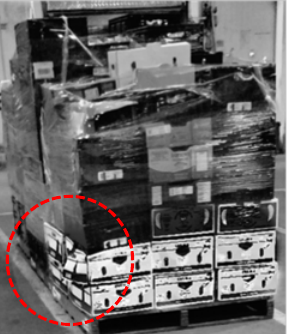
Figure 6. Package failure in